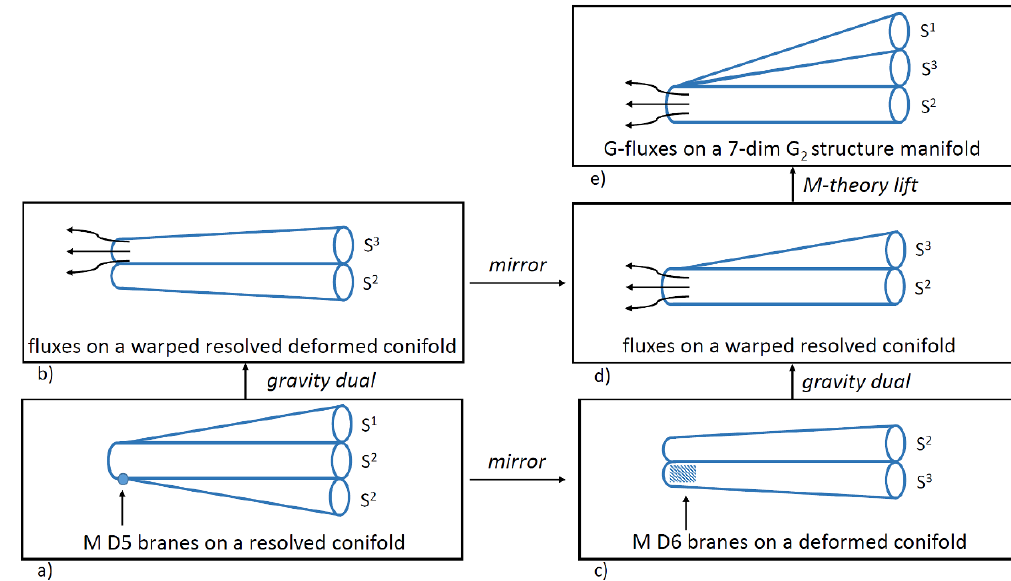
Figure 19 . The two con(cid:12)gurations, one in type IIB and the other in the M-theory uplift of type IIA, on which all the computations of sections 4 and 5 respectively will be based upon. On the left is the type IIB picture with the gravity dual given by a resolved warped-deformed conifold with (cid:13)uxes. On the right is the M-theory uplift of the type IIA gravity dual. The IIA gravity dual involes a non- K(cid:127)ahler resolved conifold with (cid:13)uxes, whereas the M-theory uplift is a seven dimensional manifold with a G 2 structure. The type IIB computations will be done at high temperatures, i.e above the decon(cid:12)nement temperatures, but with zero (cid:13)avors. The type IIA, and also the M-theory uplift, will take into account both high temperatures as well as non-zero